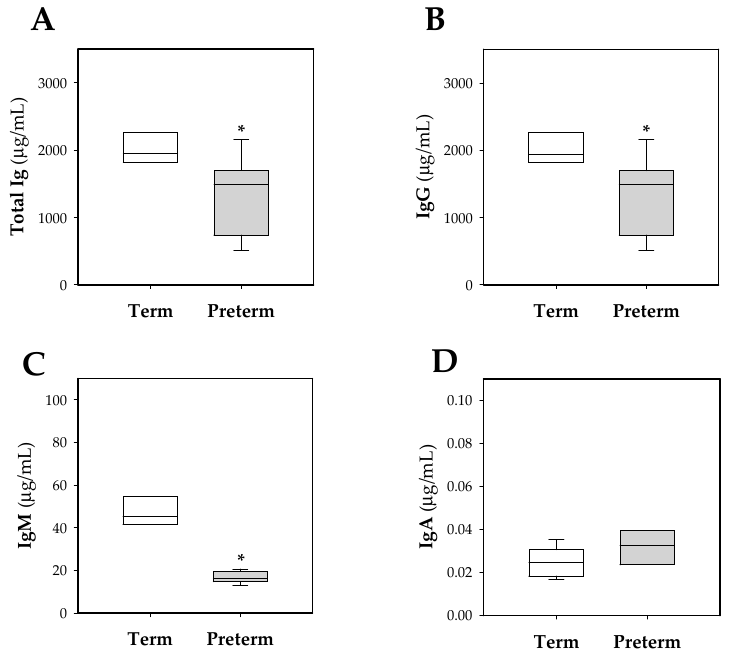
Figure 3. Box plot of plasmatic Ig concentrations at day 10 of life in both experimental groups. Total Ig ( A ), IgG ( B ), IgM ( C ), IgA ( D ). Line indicates the median, box shows the interquartile range (IQR) and the whiskers are 1.5 × IQR ( n = 10 pups per group). Statistical differences: * p < 0.05 vs. term group.